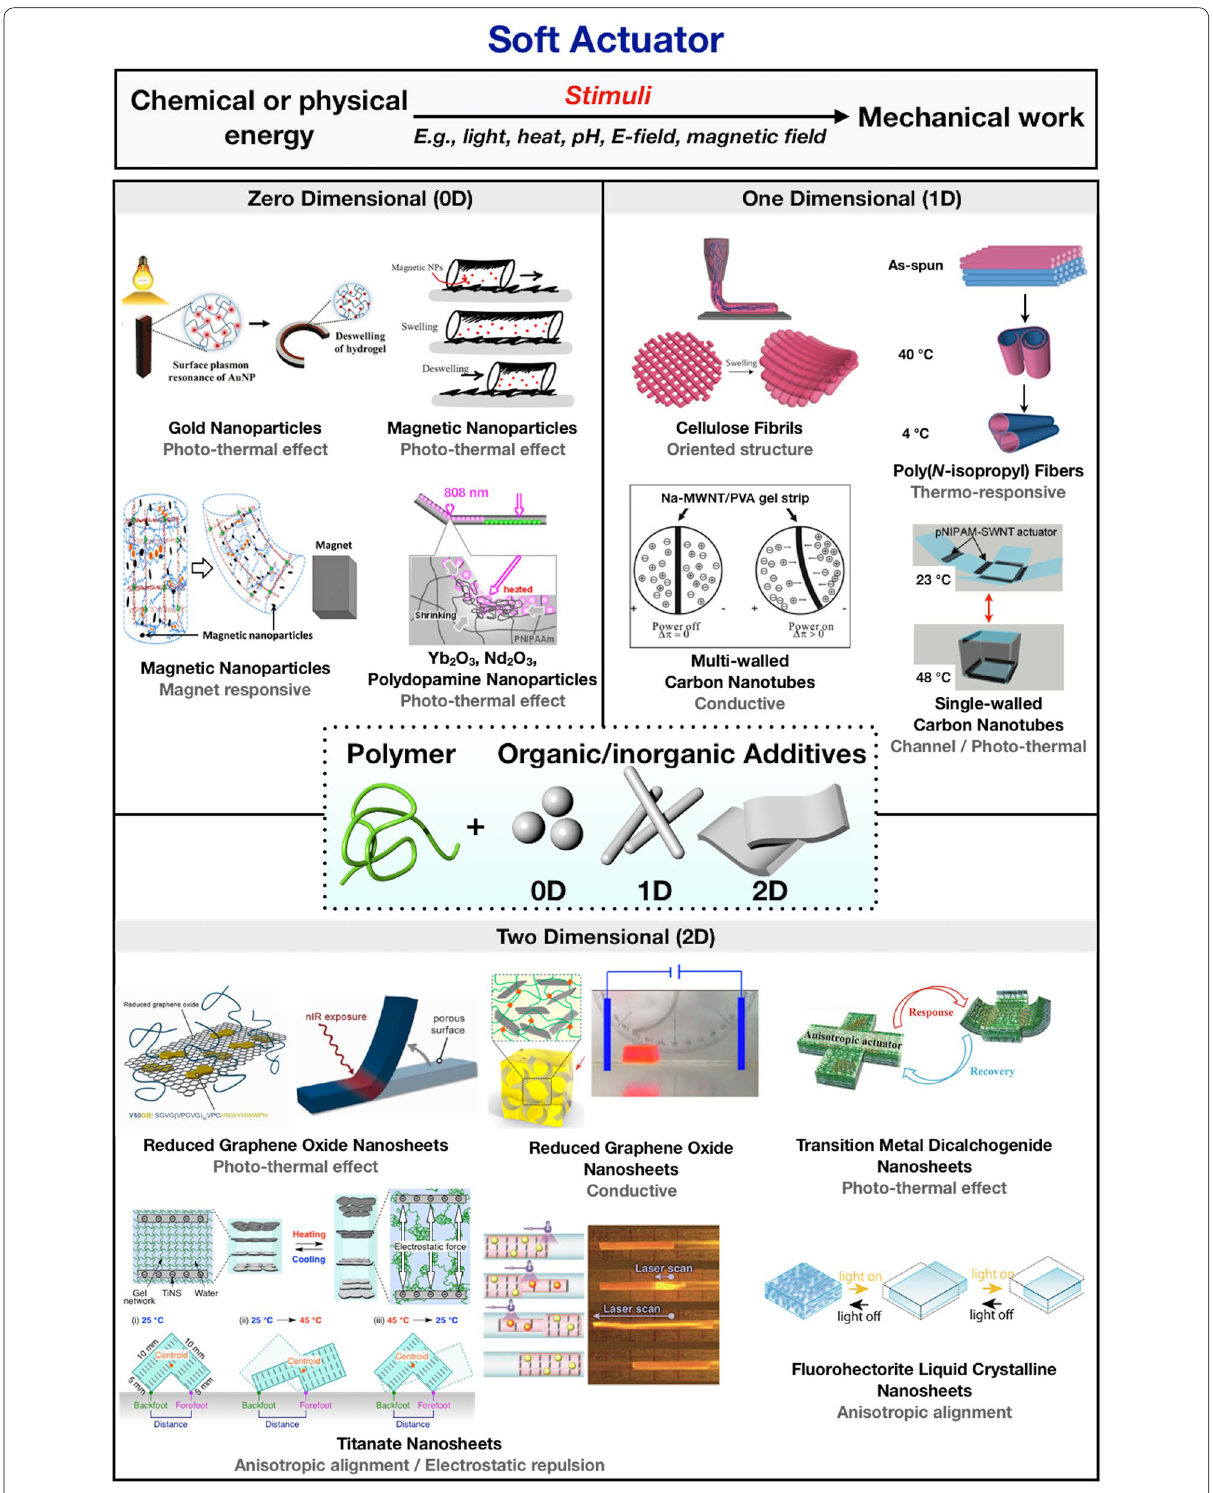
Fig. 1 Nanocomposite hydrogel actuators classified with dimensions of additive organic/inorganic